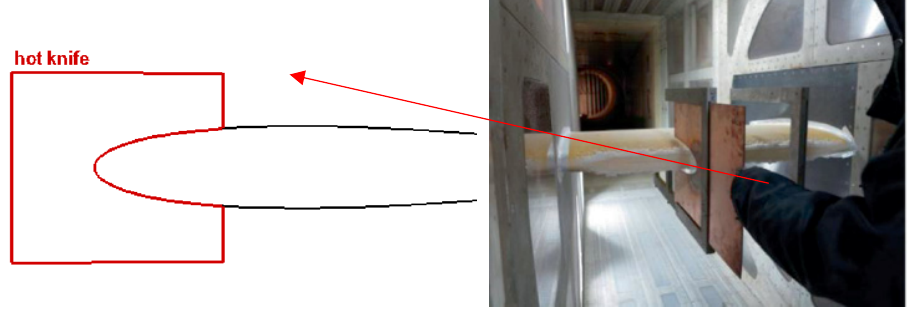
Figure 10. Hot knife used in many icing wind tunnels. After ice accumulation, ice shapes were taken at three different span locations (center line and 100 mm on the left and right sides of the center of the model as shown in Figure 11 in red curves). The ice shapes at the three different sections coincide in position and height of the ice horn well. The ice shapes presented in this paper were all obtained at the centerline position of the model.